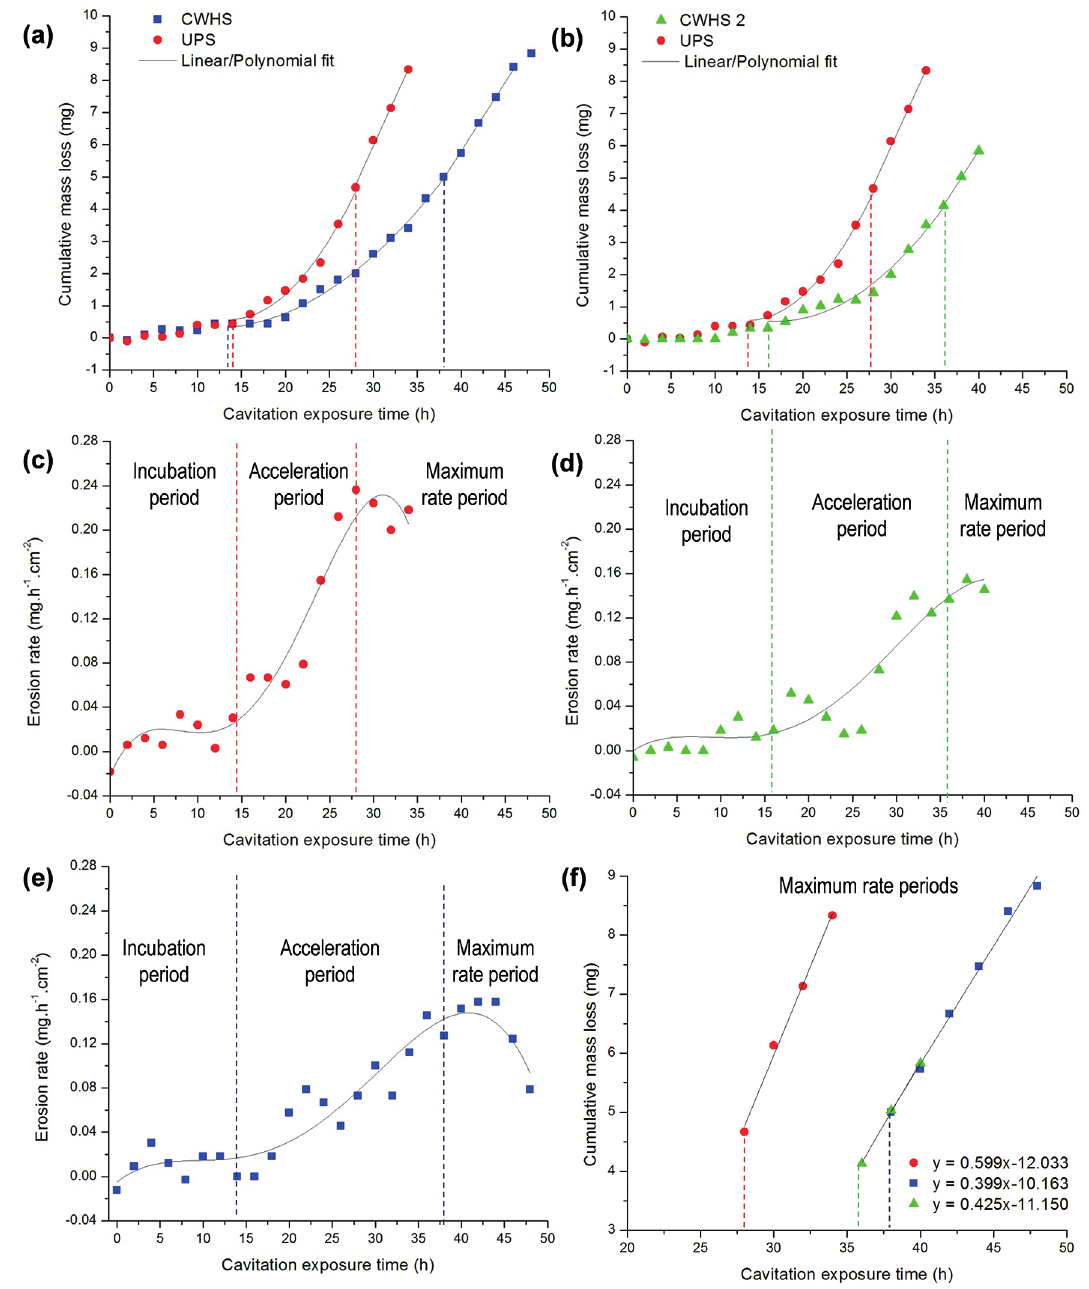
Figure 9: Cumulative mass loss and erosion rate over cavitation time for UPS, CWHS 1 and CWHS 2 specimens of Set 1. Extension of the acceleration period induced by the cold work hardening effect complete removal of the cold work deformed layer being the trigger to the onset of maximum erosion rate, it is possible to state